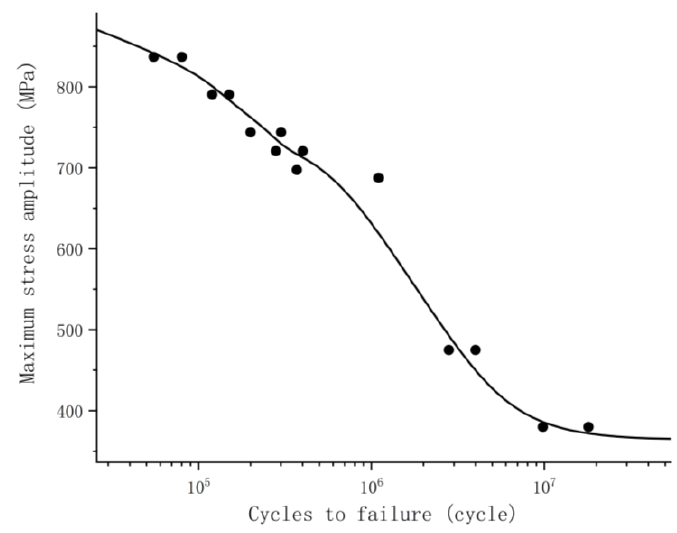
Figure 8. Local magnification of S-N curve.